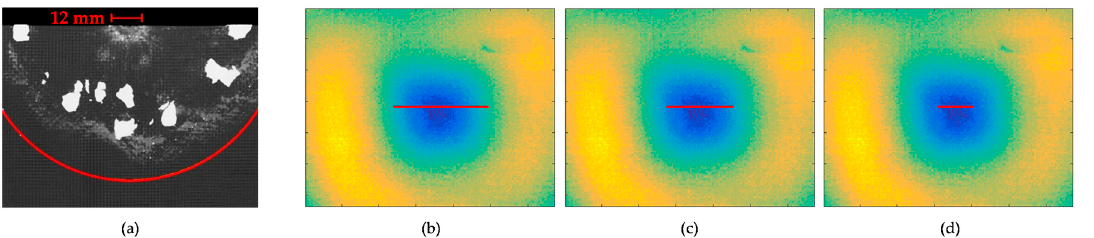
Figure 1. Equivalent damaged diameter for ( a ) X-ray technique ( b ) heating rate below 0.16 percentile (m = 1), ( c ) heating rate below 0.023 percentile (m = 2) and ( d ) 0.0013 percentile (m = 3). Image ( a ) corresponds with the specimen 23L_1 while images ( b – d ) correspond with specimen